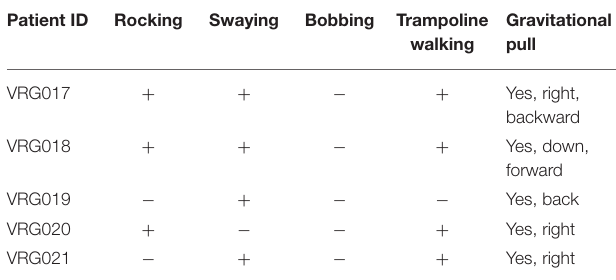
TABLE 2 | Phantom sensations of motion experienced by